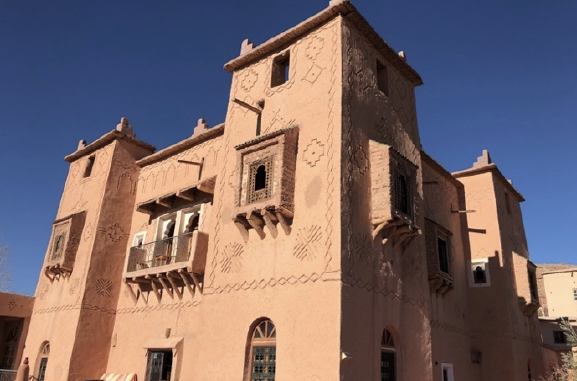
Figure 13. “Kasbah Agoulzi”, Tabarkhacht.